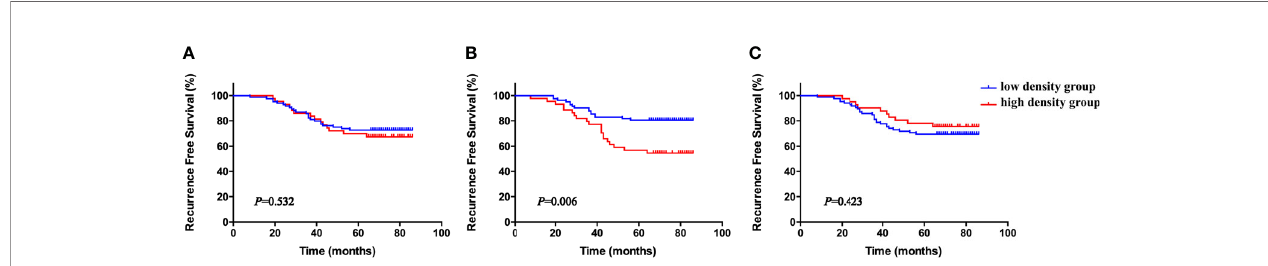
FIGURE 4 | Kaplan – Meier RFS curves according to density of whole tissue NETs (A) , stromal NETs (B) , and tumor nest NETs (C) , all strati fi ed by medians. P -values obtained from log-rank tests. RFS, recurrence-free survival.